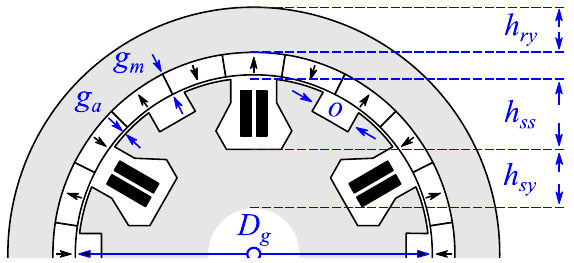
Figure 1. Basic structure of SPMVG.